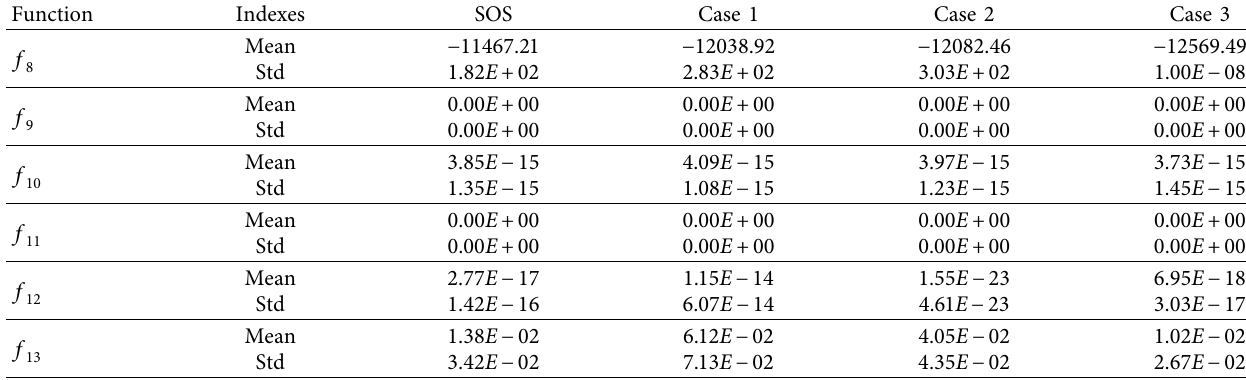
Table 7: Efect of the three cases on the SOS for multimodal functions.